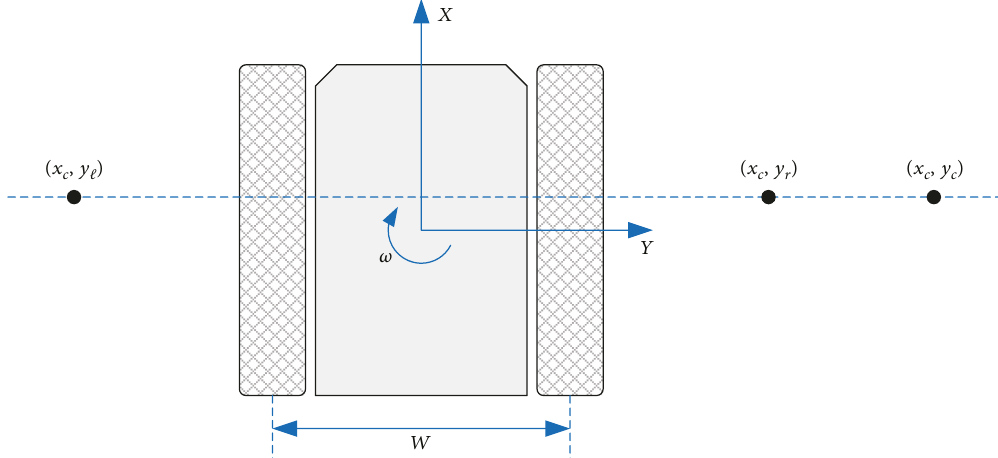
Figure 1: Schematic of the ICR locations of a tracked